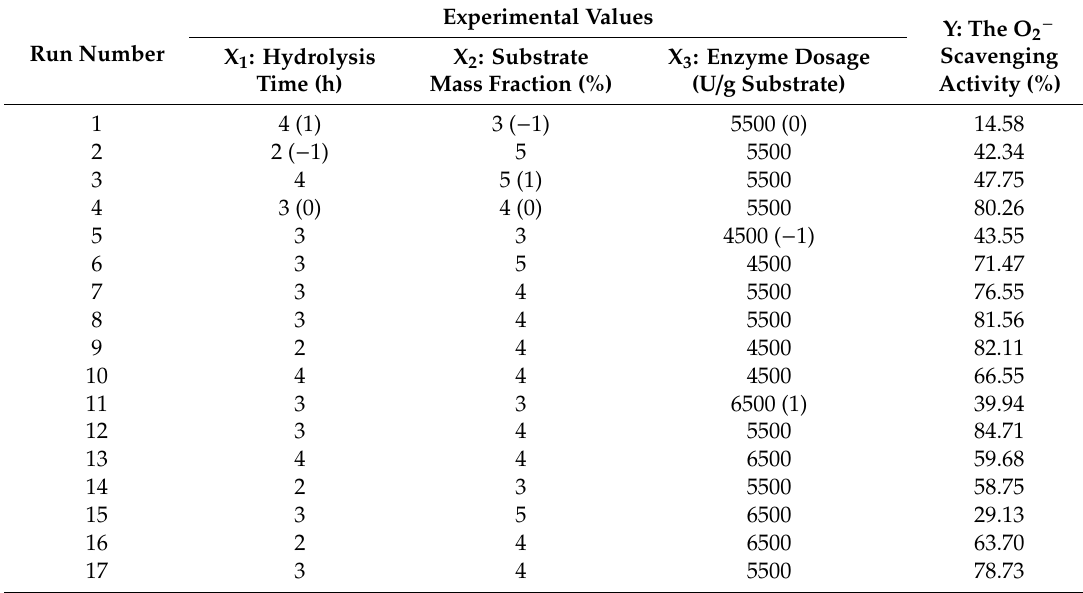
Table 1. BBD of RSM for optimizing hydrolysis conditions with the O 2 − scavenging activity.